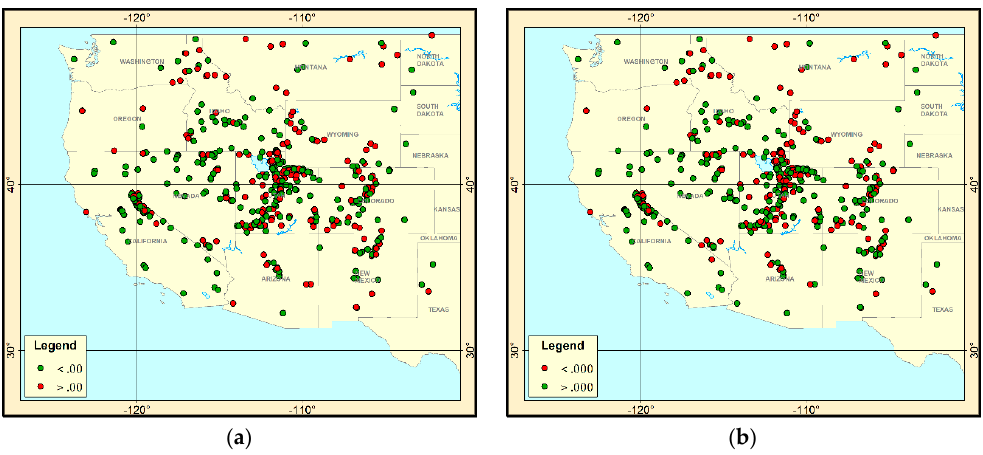
Figure 8. Spatial distribution of the difference values of ( a ) R and ( b ) ubRMSE between the fusion results with and without the GNSS-R SSM data (the former minus the latter) over each in-situ site. In general, the sites that show positive R difference values are nearly identical in number to those that show negative ubRMSE difference values. The maximum increase in R value is 0.11, while the maximum decrease in ubRMSE value is 0.012 cm 3 cm − 3 . However, less than half of the in-situ sites show an improvement after incorporating the GNSS-R network in the fusion scheme. The statistics indicate that the number of sites with a positive R difference is 205, and the number of sites with a negative ubRMSE difference is 195 out of the total 524 in-situ stations under consideration. From the perspective of the spatial distribution, the stations that show an improvement are mainly concentrated around the regions where GNSS-R sites are distributed nearby, and there are more sites showing improvements in the areas with densely distributed in-situ stations. However, it should be noted that, in the southwest part of the study area, where there are quite a few GNSS-R sites along the coast, the R and ubRMSE values for the in-situ sites in this area have become worse. The main reason for this phenomenon may be the different resolutions of the two types of data. Not only that, but the land terrain fluctuation in this region may result in low-accuracy GNSS-R SSM estimates, which affect the subsequent training process. In conclusion, the results obtained in this study demonstrate that the incorporation of the GNSS-R sites plays a limited but non-negligible part in the point-surface fusion scheme.